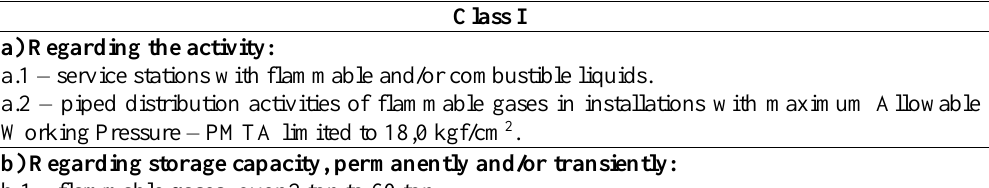
Table 1: Classification of Facilities according to NR-20.